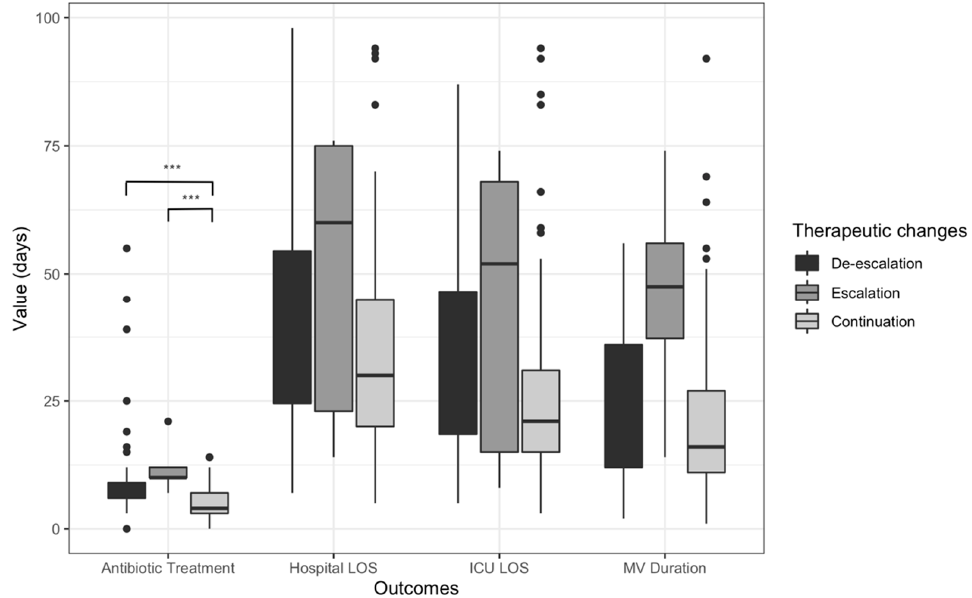
Figure 2. Graphic representation of the duration of antibiotic treatment, ICU and hospital length of stay, and mechanical ventilation according to antibiotic treatment strategy in the COVID-19 group. ***: p = 0.001